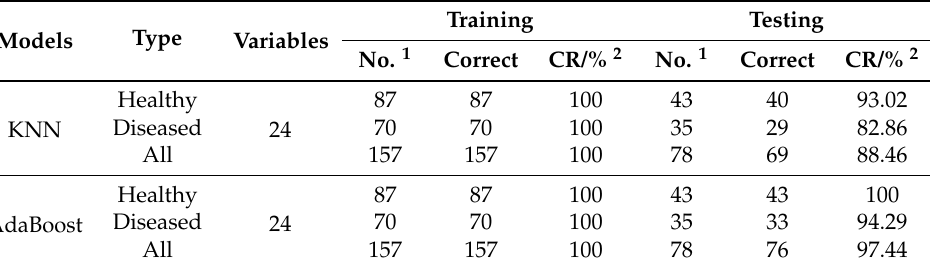
Table 6. Classification results based on HLS images.